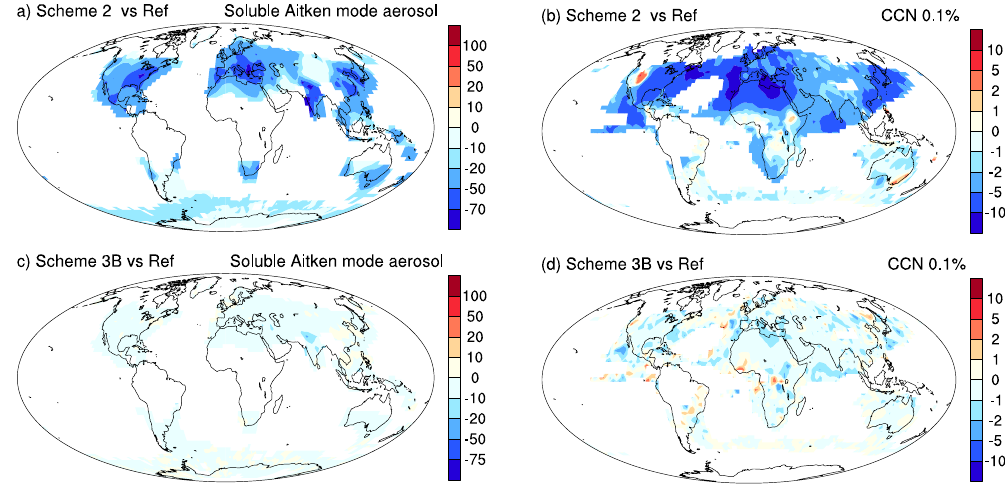
Fig. 8. Relative differences with regard to to the reference solution (unit: %) of the annual mean number concentrations of the soluble Aitken mode aerosol (left column) and the cloud condensation nuclei at 0.1 % supersaturation (CCN 0.1 %, right column) in the lowest model layer. The values are plotted only in regions with Aitken mode concentration > 500cm − 3 STP and CCN > 50cm − 3 , respectively. STP stands for standard temperature and pressure (1013.25hPa, 273.15K). The upper row shows results obtained with time integration scheme 2. The lower row corresponds to scheme